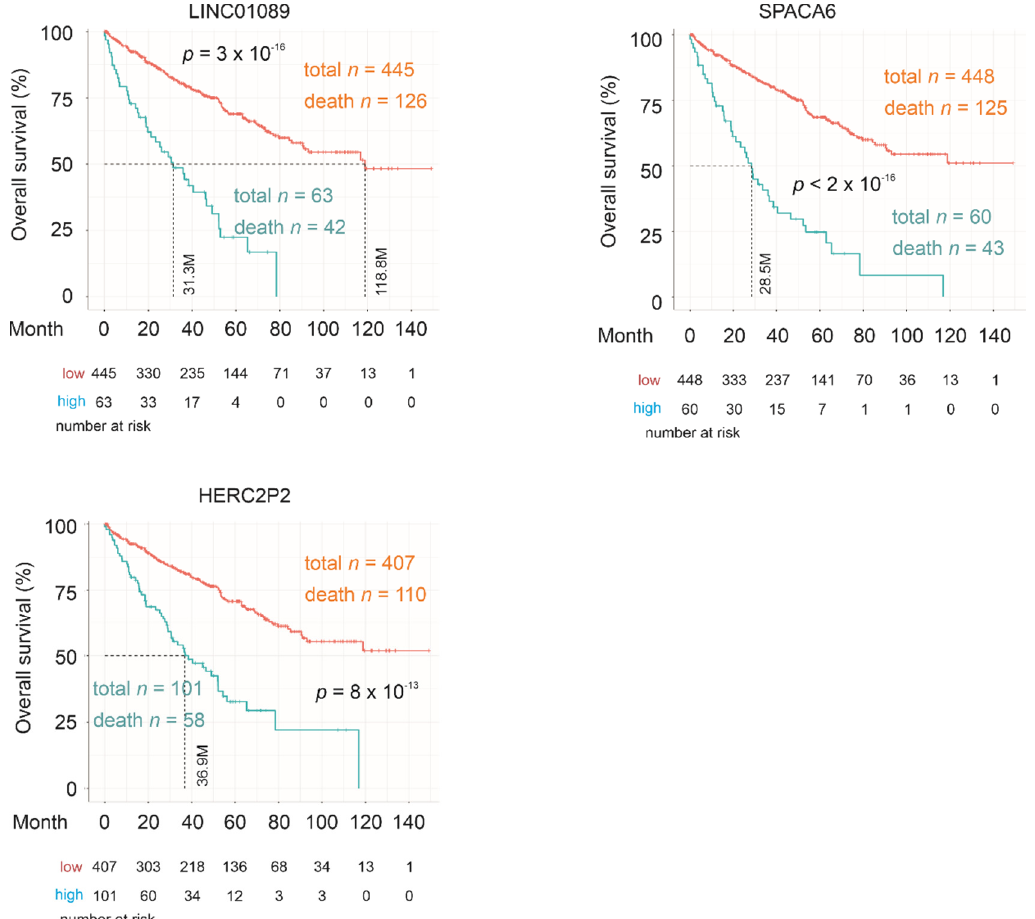
Figure 7. Association of SigIQGAP1NW component genes with poor OS of ccRCC. Kaplan Meier survival curves for the indicated component genes along with logrank p values, median survival month, and other information are included.